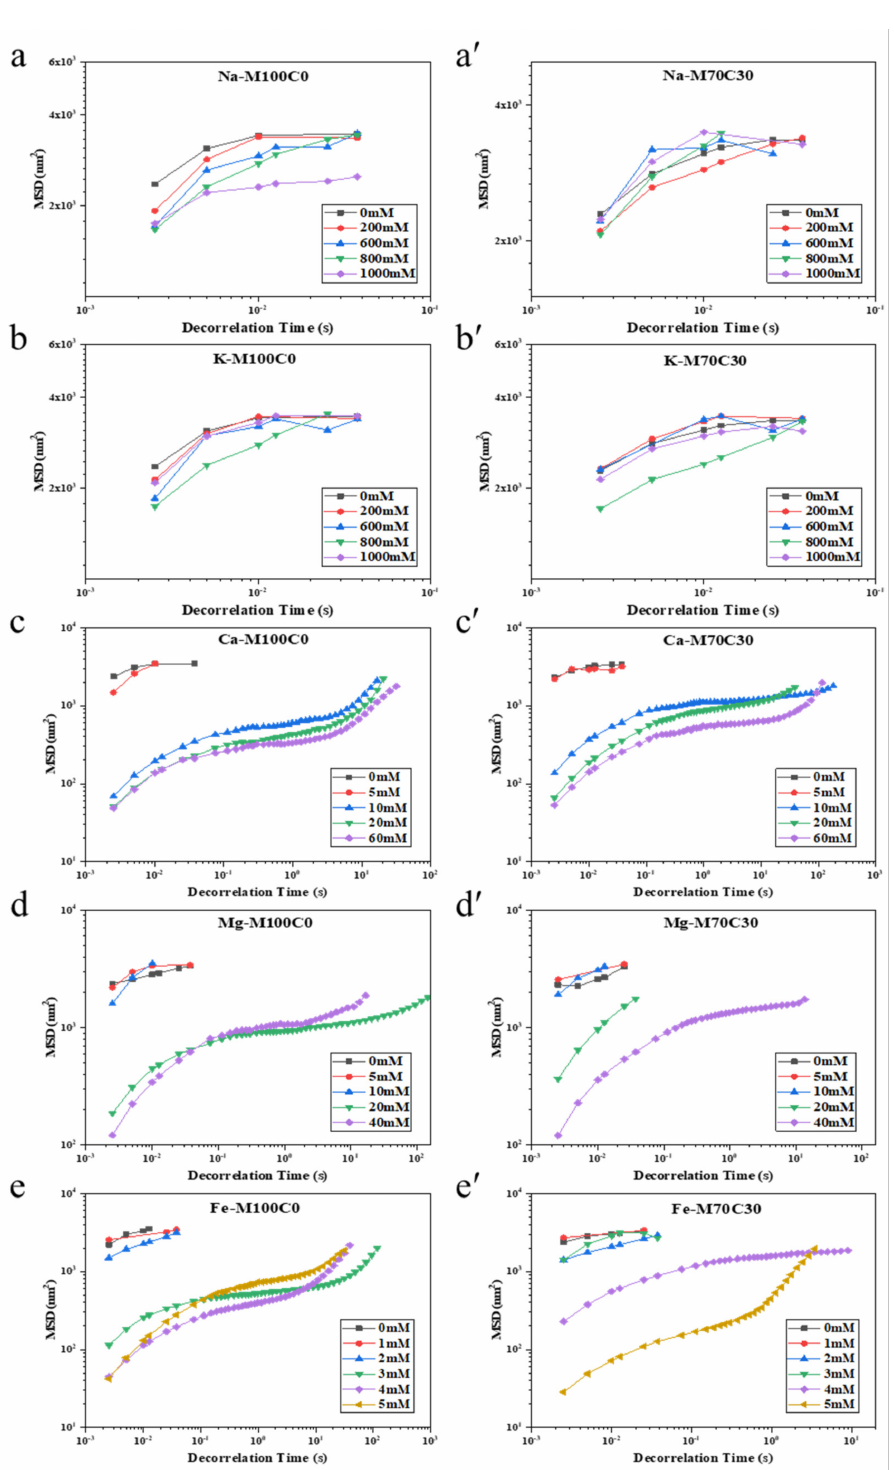
Figure 4. MSD profile versus decorrelation time curves of WPI stabilized emulsions in the absence ( a – e ) and presence ( a’ – e’ ) of CA as a function of ionic